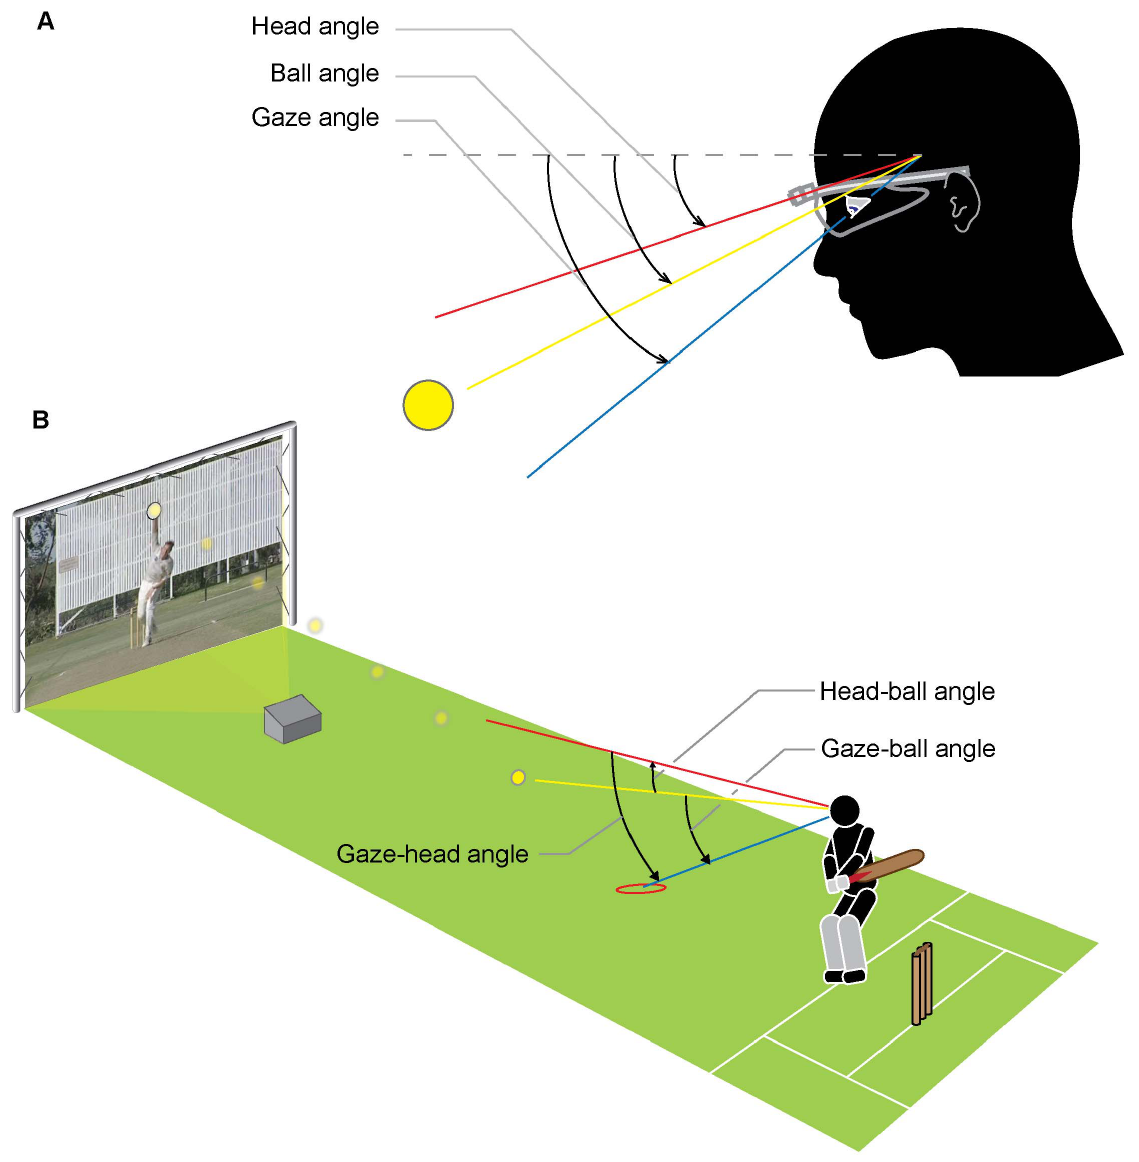
angles are subtended by direction of the ball (yellow), gaze (blue), and head (red) at the eye (in degrees) relative to the initial direction at ball-release (dotted line shows the case where all three angles coincide at ball-release). In all cases a negative angle refers to a downward direction. Panel B